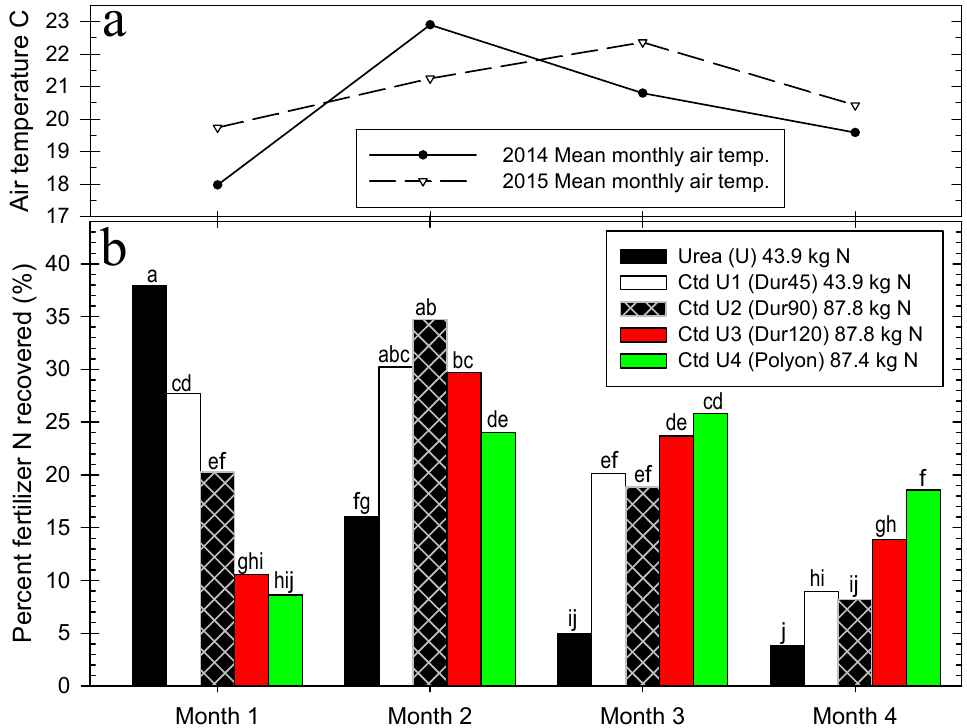
Figure 3. ( a ) The mean air temperature at experiment site by month from application and year. ( b ) Percent fertilizer N recovery of Kentucky bluegrass by fertilizer treatment (ha − 1 ) and month from application. All means denoted by common letters are not significantly different by Fisher’s Protected LSD at a 0.05 alpha level. Subtle differences in monthly percent fertilizer N recovery by the Ctd U3 and Ctd U4 fertilizer treatments were observed. Recovery of fertilizer N by Kentucky bluegrass treated with Ctd U3 (Duration 120) or Ctd U4 (Polyon) were statistically equal in Months 1 and 3 (Figure 3). In Month 2, recovery of Ctd U3 (Duration 120) fertilizer N resided in the highest statistical grouping and significantly exceeded that of Ctd U4 (Polyon). Dis- similar results were observed in Month 4, when recovery of Ctd U4 (Polyon) fertilizer N significantly exceeded all other fertilizer treatments (Figure 3). Cumulative percent ferti- lizer N recovery of the Ctd U2, Ctd U3, or Ctd U4 fertilizer treatment, each applied in mid- May at an approximate rate of 87.8 kg N · ha − 1 , was 82, 78, or 77%, respectively. 3.5. Unaccounted Fertillizer N The fate of nitrogen in fertilizers applied to turfgrass is the subject of great horticul- tural interest. Extraordinary field research effort has been applied to accounting the mass balance and fate of applied fertilizer N [48–51]. While the research described herein di- rectly quantified only assimilation and vegetative investment of fertilizer N via offtake, indirect inference of the conjugate may afford the reader greater appreciation for the treat- ment array employed. Following 18 weeks of recovery effort in two successive growing seasons, paired-sample t-tests showed that the mean unaccounted fertilizer N associated with the 43.9 kg N · ha − 1 conventional urea treatment did not significantly differ from that of any 87.8 kg N · ha − 1 granular PCU treatments at every alpha level < 0.7. On the other hand, unaccounted fertilizer N associated with the 43.9 kg N · ha − 1 Ctd U1 (Duration 45)